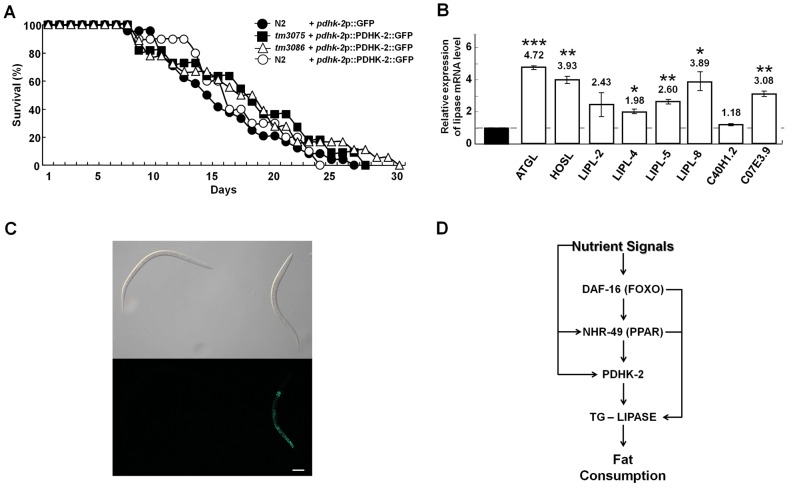
Effect of PDHK-2 overexpression.(A) Lifespan analysis of PDHK-2 overexpression in N2 wild-type. pdhk-2p::PDHK-2::GFP was microinjected into N2 worms and the pdhk-2 mutants, tm3075 and tm3086; N2 injected with pdhk-2p::GFP was used as a control. (B) Changes in lipase expression in PDHK-2-overexpressing N2 worms after 12-hour under starvation conditions. All data were normalized to control worms under 12-hour starvation conditions. *p<0.05, **p<0.01 and ***p<0.001 compared with the control. The values represent means [±SDs] from two independent experiments. (C) Effect of PDHK-2 overexpression in daf-2(e1370) dauer stage worms. In the lower panel, normal dauer worms (on the left) do not express GFP, whereas worms exhibiting abnormal dauer formation do express GFP (on the right). Scale bar: 50 µm. (D) Role of PDHK-2 under nutritionally adverse conditions in C. elegans. Shown is the proposed role of PDHK-2 in the maintenance of fat reservoirs in starved or dauer larvae, which depend on their fat supply for long-term survival. Nutrient signals act through DAF-16 and/or NHR-49 (or through a separate, currently unidentified mechanism) to regulate PDHK-2, which in turn appears to control the expression of lipases.